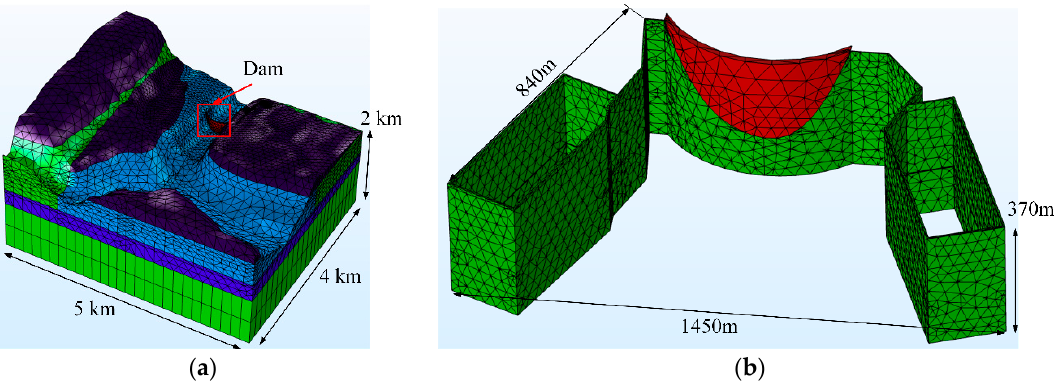
Figure 11. Finite element model of the reservoir area: ( a ) reservoir area; ( b ) arch dam and grouted Figure11. Finiteelementmodelofthereservoirarea: ( a )reservoirarea; ( b )archdamandgroutedcurtain. curtain.